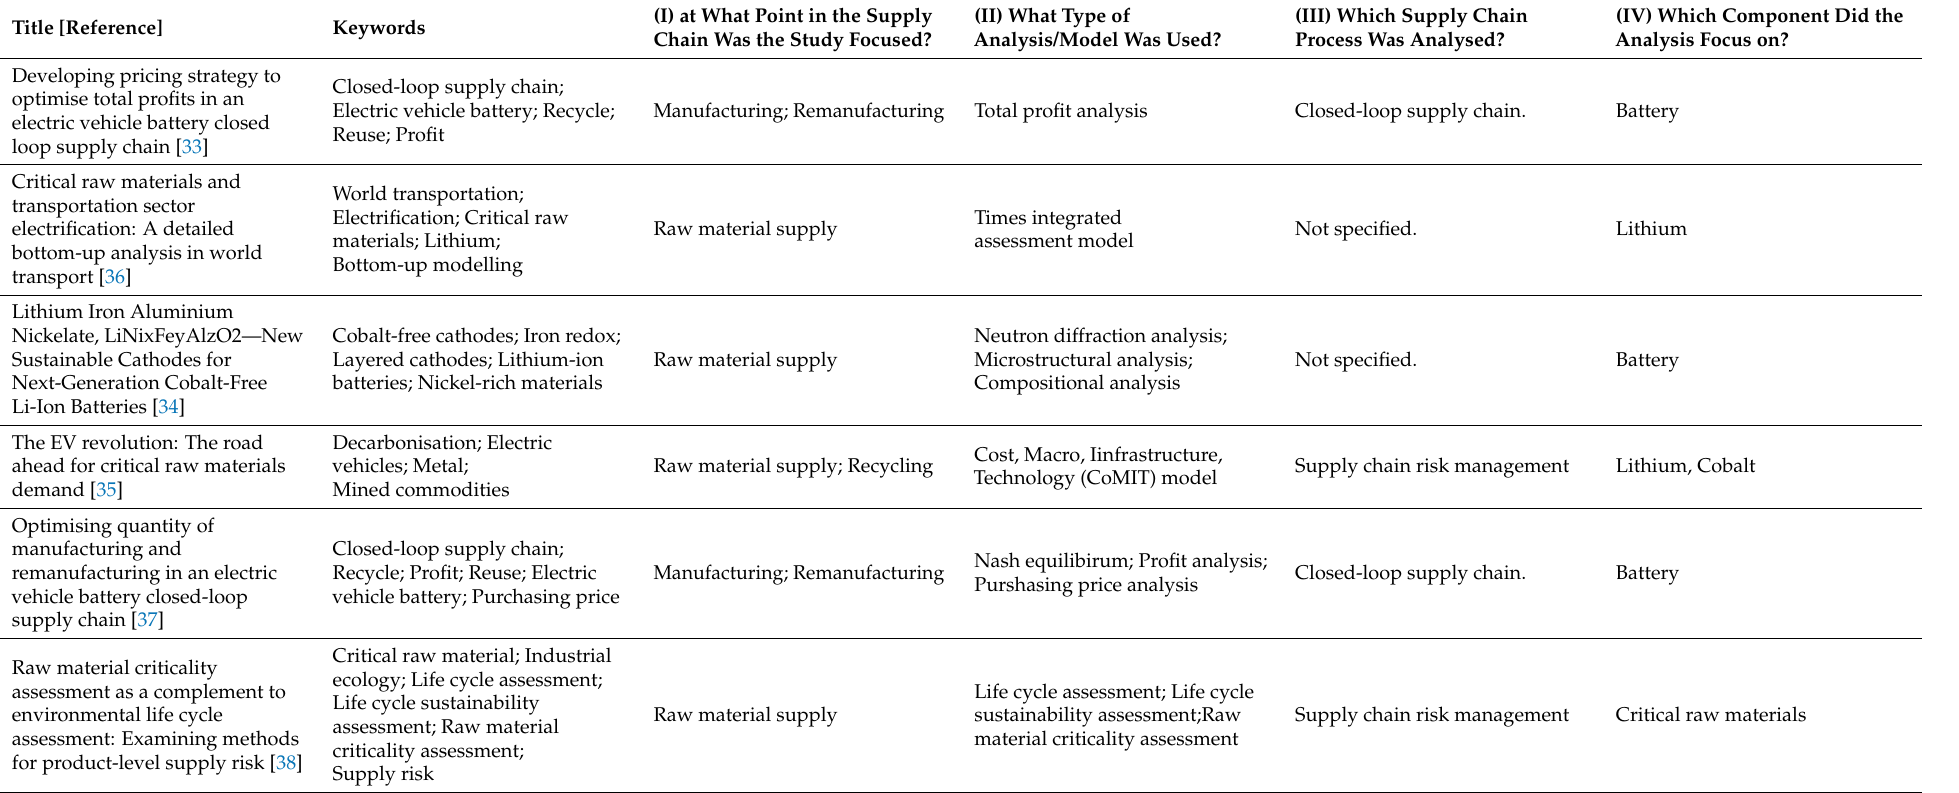
Table A2. PRISMA meta-analysis of documents found related to electric vehicles supply chains.